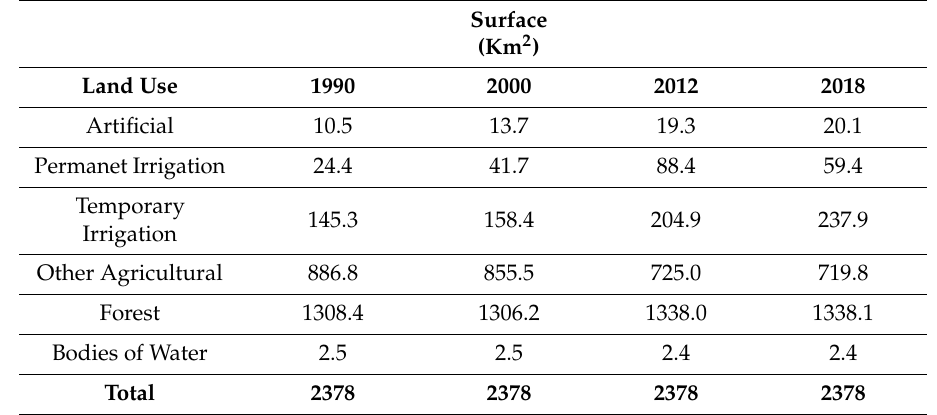
Table 2. Temporal evolution of land use distribution (Corine Land Cover (CLC) 1990, 2000, 2012 and 2018).